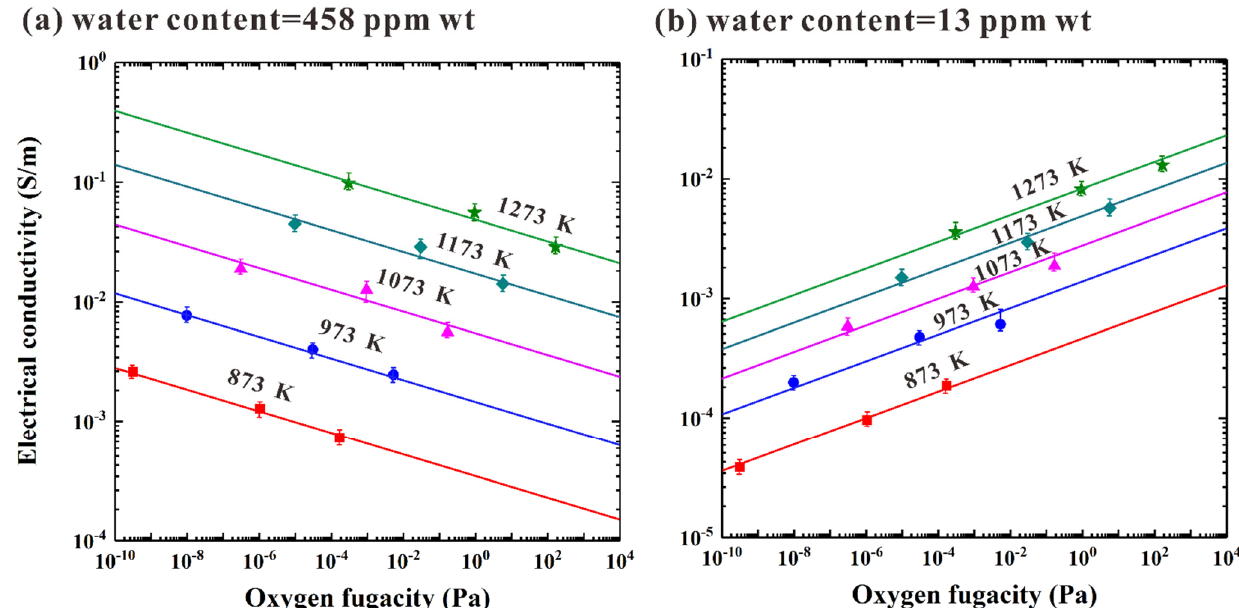
Figure 6. The electrical conductivity of dry (13 ppm wt) and hydrous (458 ppm wt) polycrystalline olivine aggregates with the correspondent TiO 2 content of 683 ppm wt as a function of the variation of oxygen fugacity at 4.0 GPa, temperatures range from 873 to 1273 K and controlled different oxygen fugacities. In here, ( a ) stands for the high Ti-doped hydrous sample, and as well as ( b ) stands for the high Ti-doped dry sample, respectively. The oxygen fugacity is efficiently controlled by three solid oxygen buffers including the rehnium and rehnium dioxide (Re–ReO 2 ), nickel and nickel oxide (Ni–NiO), and molybdenum and molybdenum dioxide (Mo–MoO 2 ). The FTIR measurement results indicated that the water contents of dry and hydrous polycrystalline olivine aggregates are 13 and 458 ppm wt, respectively (reproduced with permission from the reference of Dai and Karato [9]; published by the American Geophysical Union, 2020).